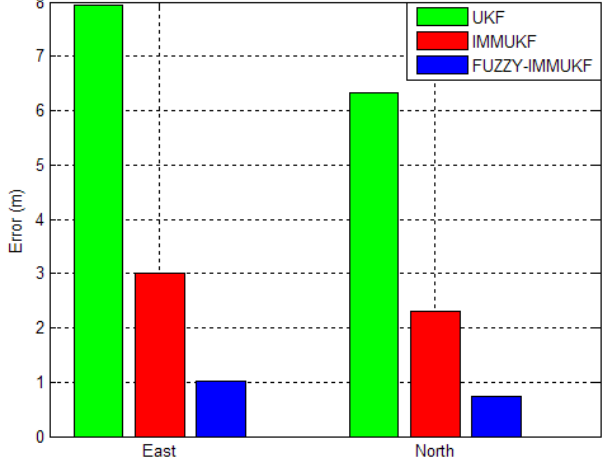
Figure 15. Comparisons of east and north position RMS errors via three approaches: UKF, IMMUKF and FUZZY-IMMUKF.